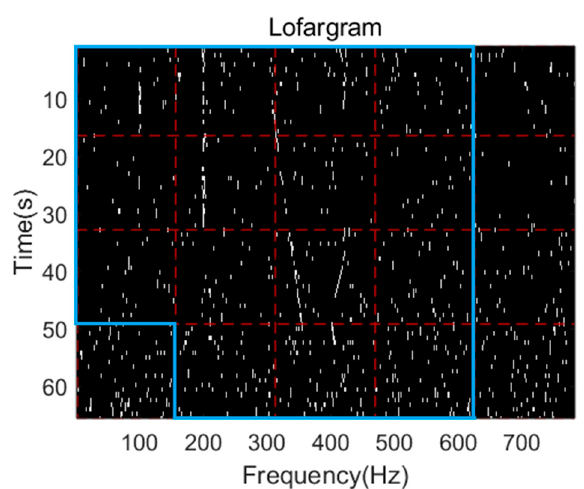
Figure 11. Segmentation.